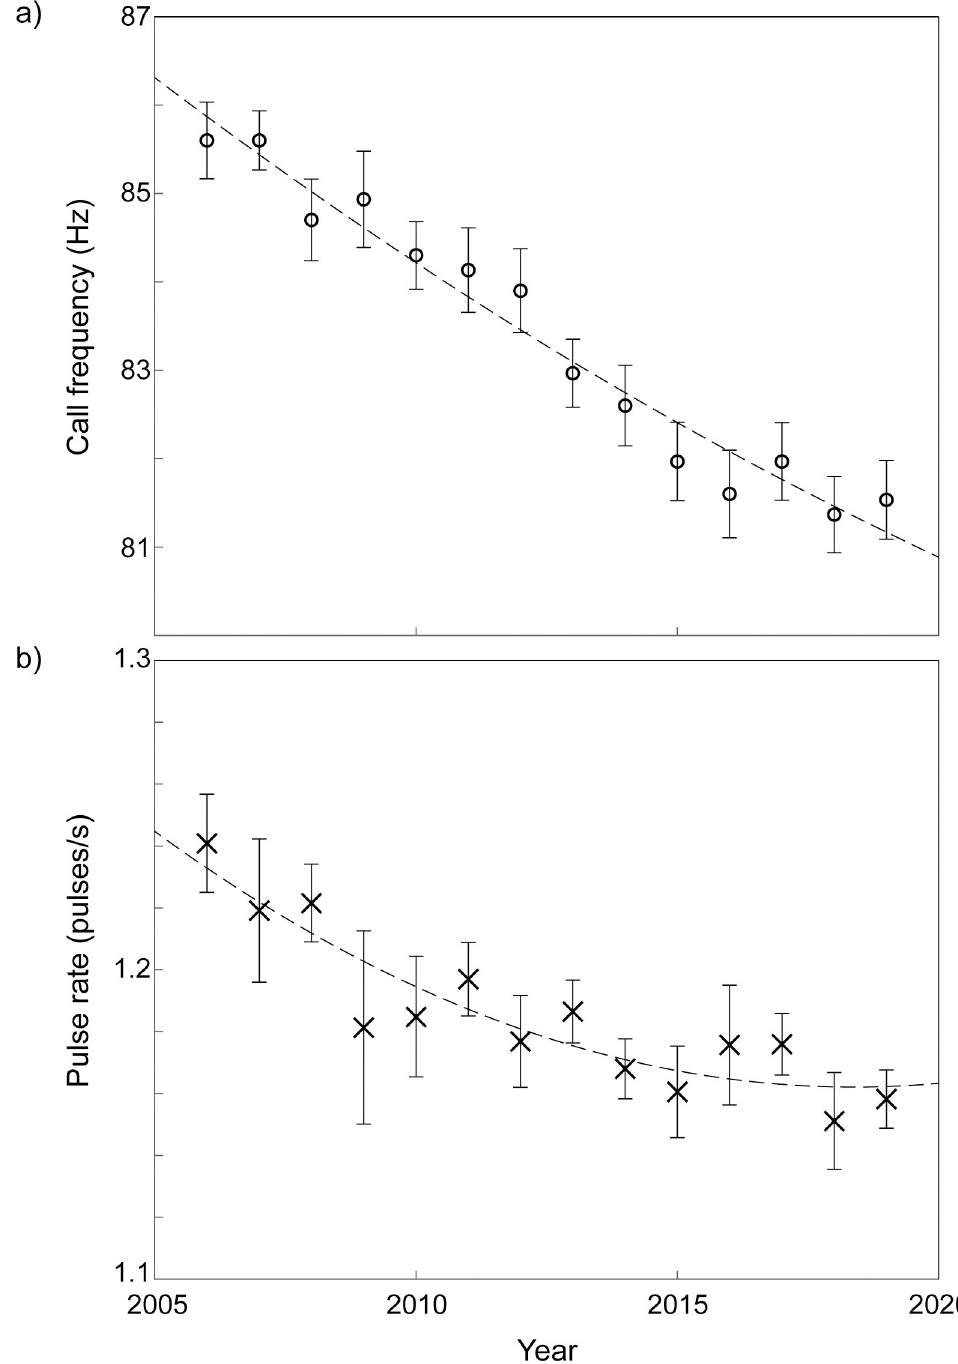
Fig 4. Mean frequency (a) and pulse rate (b) of Northeast Pacific blue whale A calls from 2006 to 2019. Error bars represent 95% confidence intervals and the dashed black line represents a quadratic fit to the data.